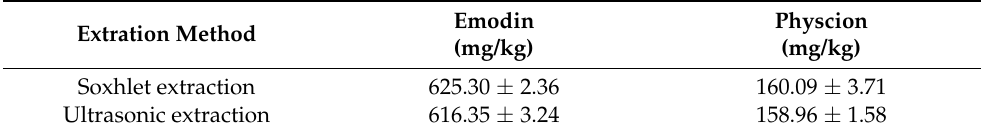
Table 2. A comparison of ultrasonic extraction and Soxhlet extraction ( n =